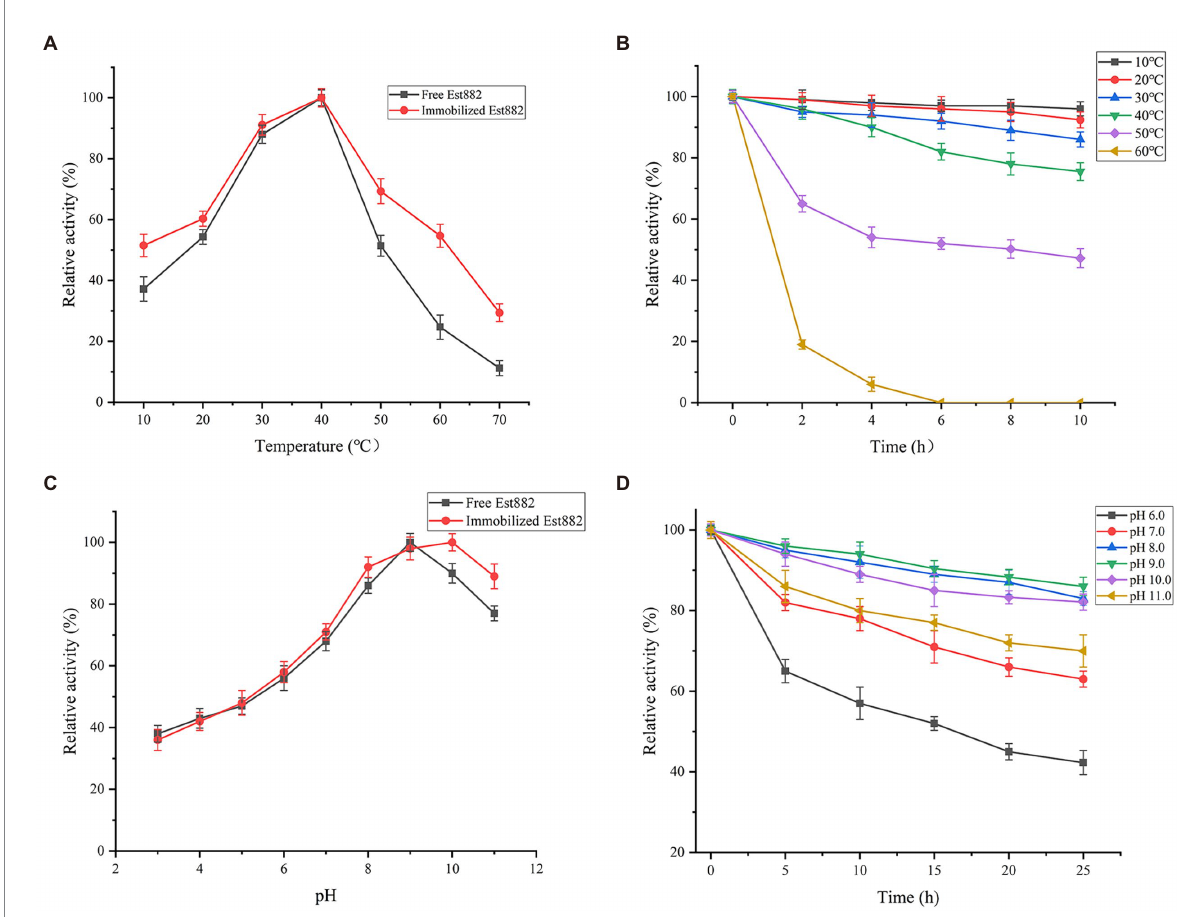
FIGURE 8 Effects of (A) temperature and (C) pH on the activity of free Est882 (square) and immobilized Est882 (circle). (B) Thermal stability and (D) pH stability of immobilized Est882. Symbols: square: 10 ° C. circle: 20 ° C. upward triangle: 30 ° C. downward triangle: 40 ° C. diamond: 50 ° C. left triangle: 60 ° C. Symbols: square: pH 6.0. circle: pH 7.0. upward triangle: pH 8.0. downward triangle: pH 9.0. diamond: pH 10.0. left triangle: pH